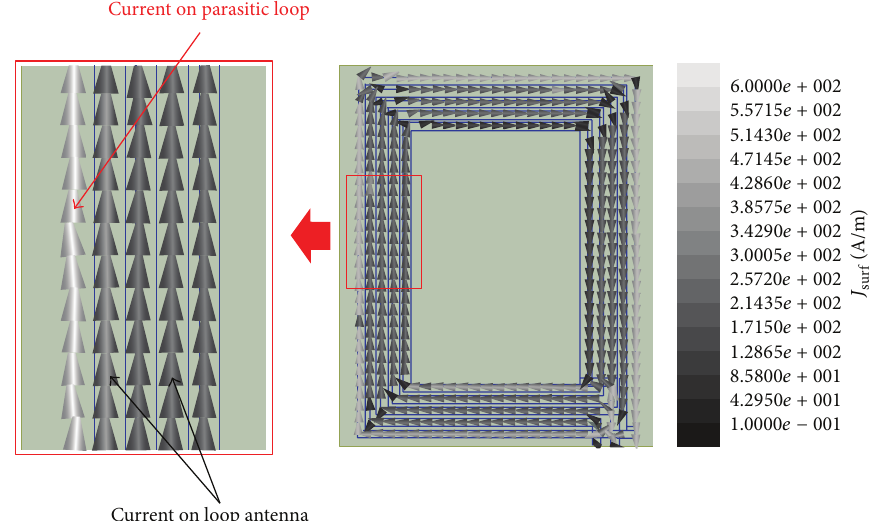
Figure 5: Current direction on the proposed loop antenna with the parasitic loop embedded capacitor (800 pF).